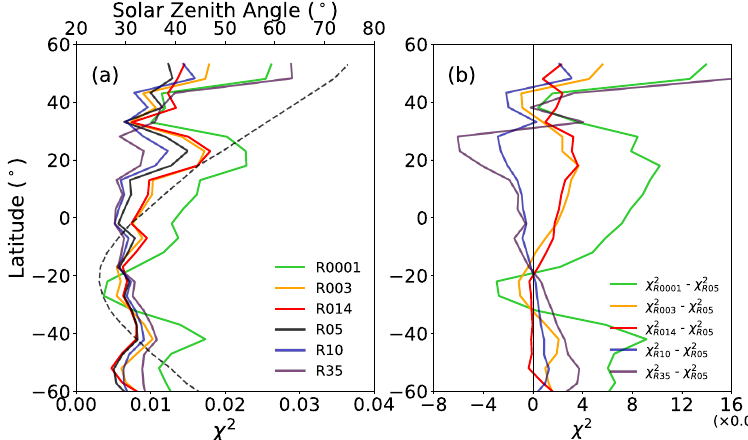
Figure 7. The same as Figure 3 but computed for thick homogeneous clouds only. ( a ) The χ 2 using the R0001, R003, R014, R05, R10, and R35 ice particle models on December solstices from 2012 to 2015. The dotted curve (and top scale) is the median SZA as a function of latitude. ( b ) The χ 2 value using each corresponding model minus the χ 2 value using the R05 ice particle model as a function of latitude.